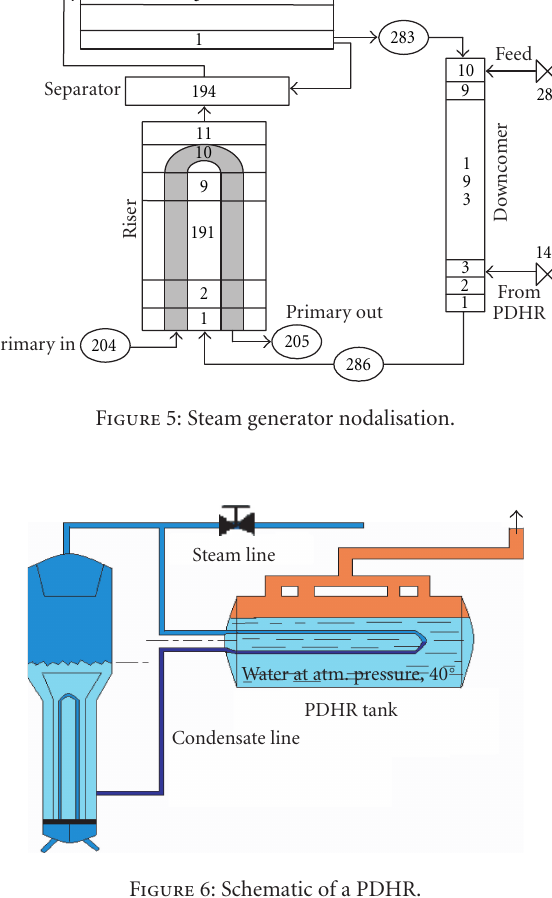
Figure 6: Schematic of a PDHR.